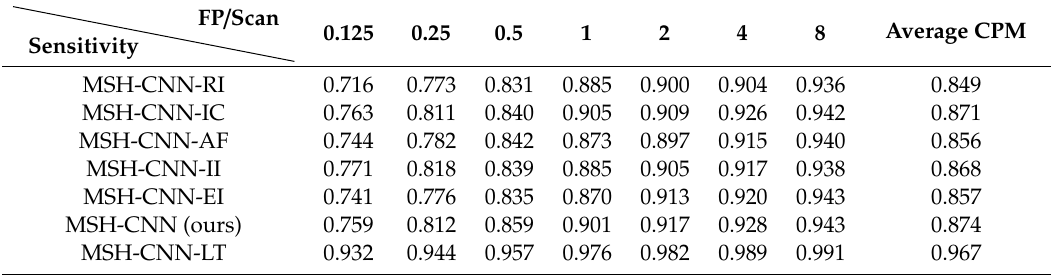
Table 5. CPM scores of di ff erent structure networks. MSH-CNN-RI radically integrates nodule blocks; weights; MSH-CNN-II has both branches containing inception; MSH-CNN-EI has neither